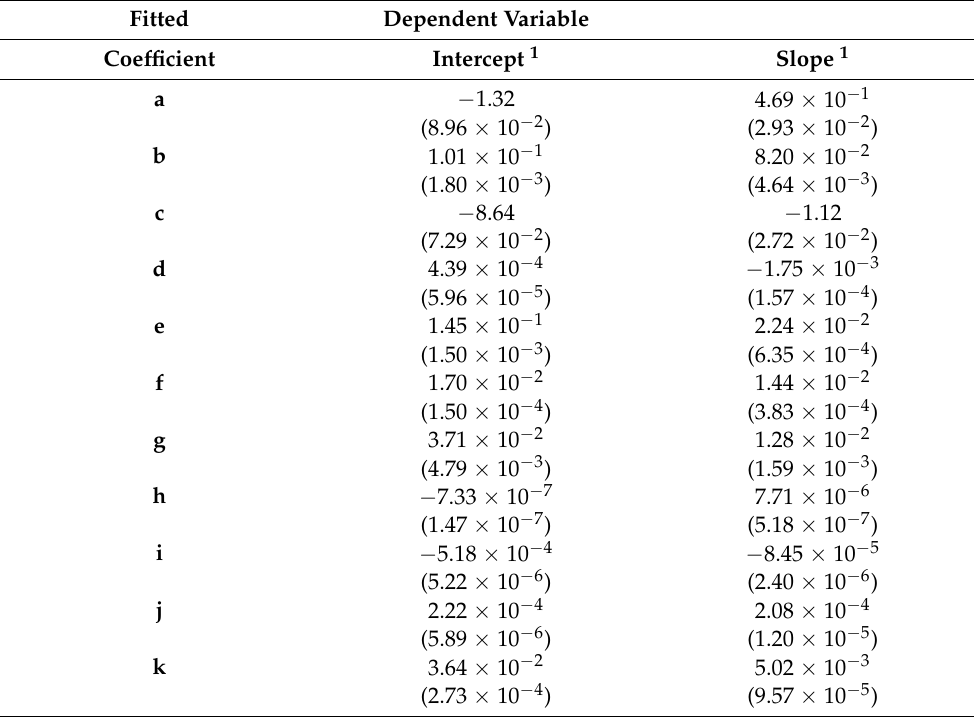
Table 4. Fitted coefficients and their standard errors (in parentheses) of the mathematical models, as shown in Equations (7) and